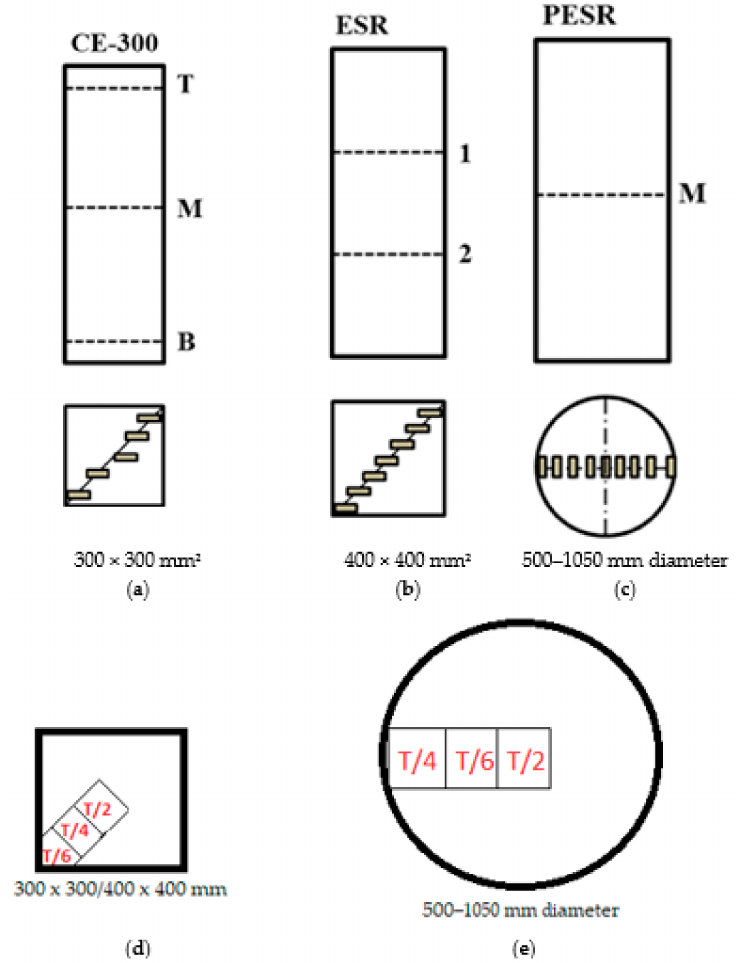
Figure 2. Schematic illustration of horizontal slices and position of the micro sample on ( a ) the consumable electrode, CE-300, ( b ) ESR remelted ingots, and ( c ) PESR remelted ingots. Schematic illustration of the positions of the macro samples for ( d ) the electrode 300 × 300 mm 2 , for the electro- slag remelted (ESR) ingot 400 × 400 mm 2 , and ( e ) the pressure electro-slag remelted (PESR) ingots 500-1050 mm in diameter. Position T/2 is located in the center of the electrode/ingot, T/4 in between the center and the surface/corner, and T/6 in between position T4 and the